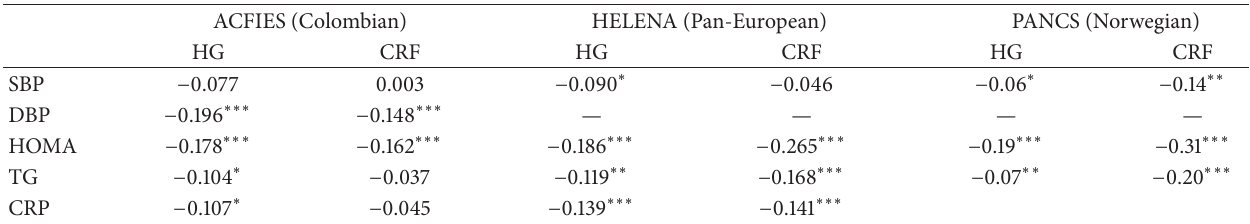
Table 1: Relationship between handgrip strength (HG), cardiorespiratory fitness (CRF) and cardiometabolic risk factors in children and adolescents. ACFIES (Colombian) HELENA (Pan-European) PANCS